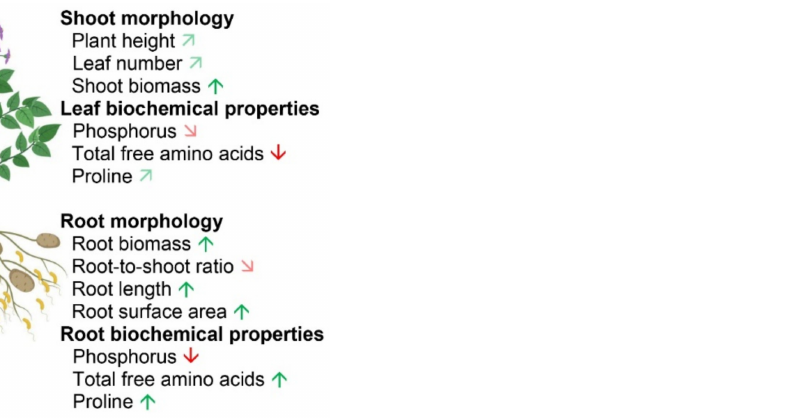
Figure 9. Summary of the morphological and biochemical responses of the potato plants to PGPR inoculation under P deficiency. Green and red arrows indicate significant increase and decrease ( p ≤ 0.05), respectively, compared to optimum P condition. Light green and light red diagonal arrows indicate a tendency of increase and decrease, respectively. Figure 9 was created using